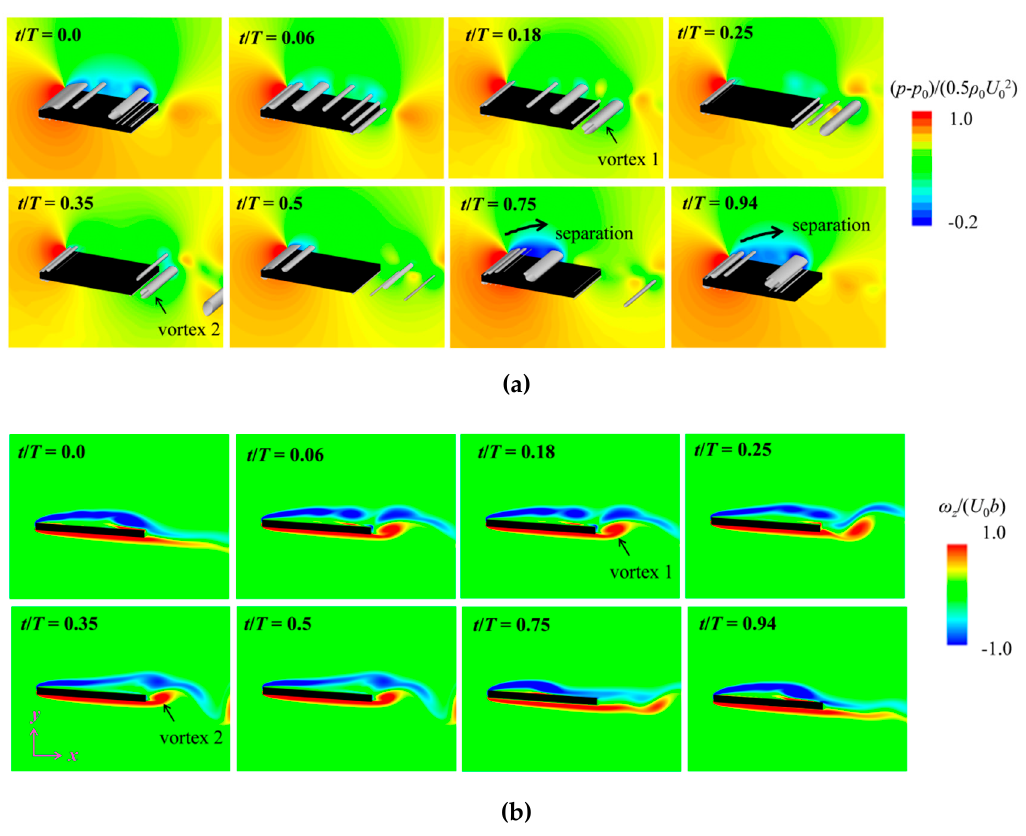
Figure 13. The flow field around the oscillating plate in the baseline flow. ( a ) The iso-surfaces of second invariant ( q /( U 0 / b ) 2 = 0.1) of velocity gradient tensor and contours of pressure coefficient ( p - p 0 )/(0.5 ρ 0 U 02 ), where p 0 is the ambient pressure; ( b ) The contours of vorticity.